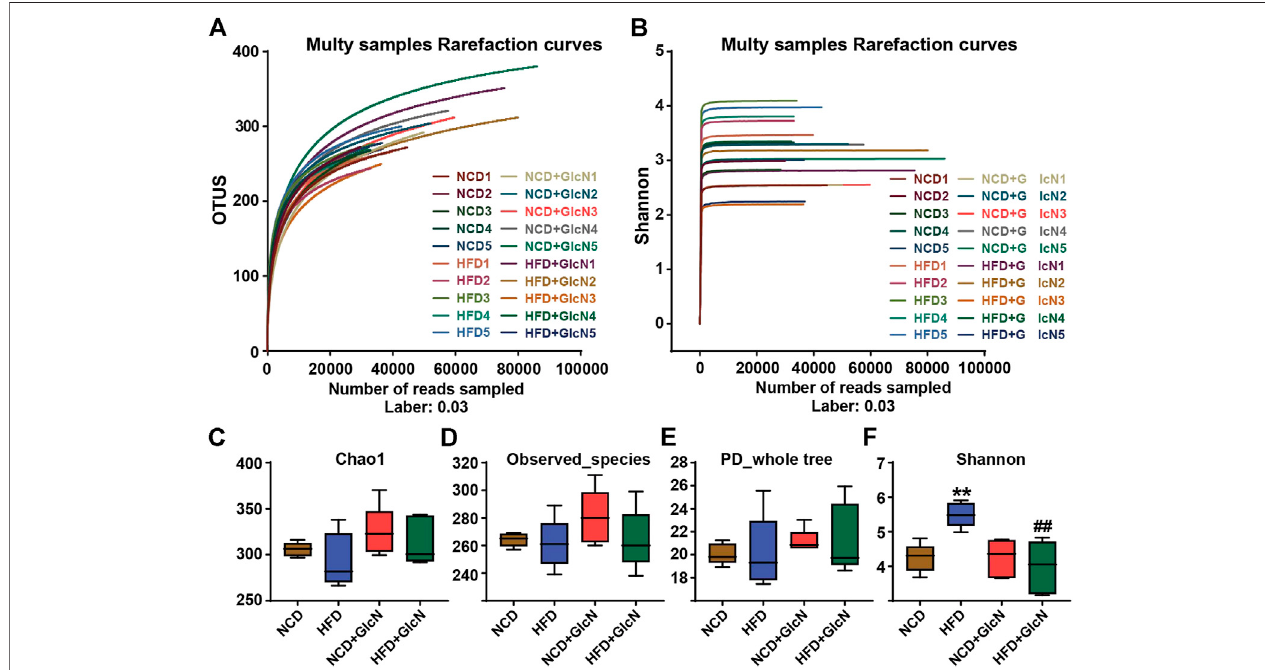
FIGURE 2 | Sequencing data validation and diversity analysis of gut microbiota among experimental groups. After the treatment with NCD, HFD, and/or GlcN (1 mg/ml, in drinking water) for 5 months, all mice were sacri fi ced and the cecal contents were collected for 16S rDNA sequencing. Rarefaction curve (A) and Shannon- Wiener curve (B) weredrawnbytheOTUnumber sampled. IndicesofChao1 (C) ,observed_species (D) ,PD_whole_tree (E) ,and Shannonindex (F) wereused forthe α diversity analysis. Data were shown as means ± SEM ( n (cid:1) 5). ** p < 0.01 indicates the difference between HFD group and NCD group; ## p < 0.01 indicates the difference between HFD + GlcN group and HFD